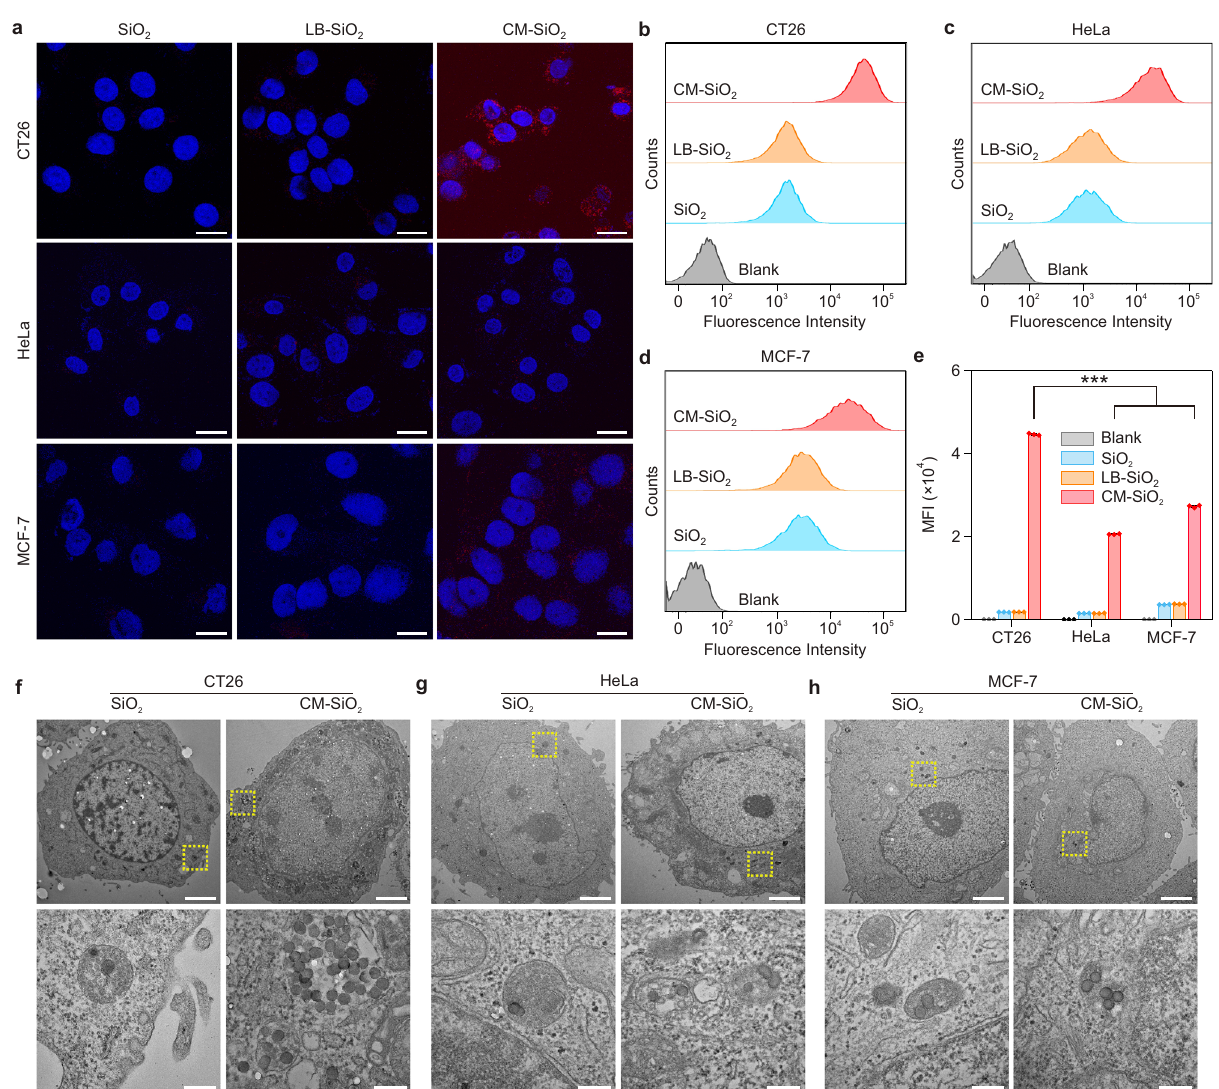
Fig. 3 In vitro characterization of the homologous targeting capabilities of CM-SiO 2 NPs. a Representative CLSM images of three cell lines (CT26, HeLa and MCF-7) after 4 h incubation with SiO 2 NPs, LB-SiO 2 NPs and CM-SiO 2 NPs. The SiO 2 cores were labeled with Cy5 (red), and the cell nuclei were stained with 4 ’ ,6-diamidino-2-phenylindole (DAPI; blue). Scale bars, 20 μ m. b – d Flow cytometric analysis of CT26 cells ( b ), HeLa cells ( c ) and MCF-7 cells ( d ) incubated with blank solution, SiO 2 NPs, LB-SiO 2 NPs and CM-SiO 2 NPs. e Quanti fi cation of the mean fl uorescence intensities for the three cell lines (CT26, HeLa, and MCF-7). Data represents mean ± SD ( n = 3). One-way ANOVA followed by post hoc Tukey test was used to determine the signi fi cance of data. *** p < 0.001. f – h TEM images of CT26 cells ( f ), HeLa cells ( g ), and MCF-7 cells ( h ) after 4 h incubation with SiO 2 NPs and CM-SiO 2 NPs. Insets below are magni fi ed of each image in the area highlighted with the respective yellow dashed box. Scale bars, 2 μ m (top); 200 nm